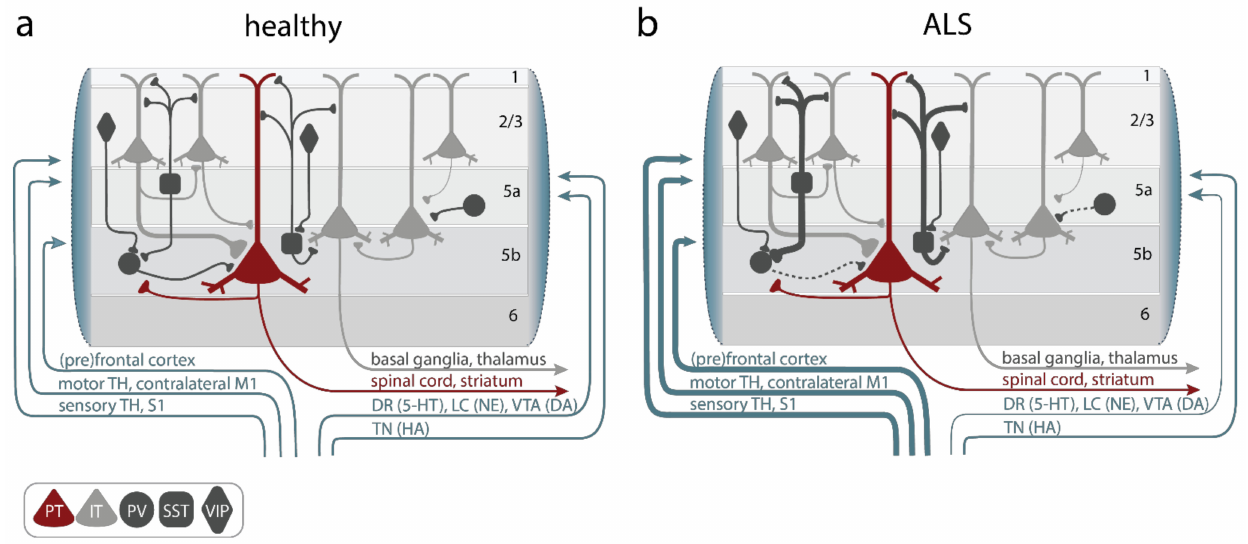
Figure 2. Alterations of primary motor cortex (M1) microcircuit elements in ALS. ( a ) In the healthy M1 microcircuitry upper motor neurons (UMNs), aka, pyramidal tract neurons (PT, red), located within cortical layer 5b receive feedforward excitatory synaptic input primarily from intratelencephalic (IT, light gray) neurons in layer 2–3 and, to a lesser degree, intralaminarly from layer 5 IT. Long- range feedforward input is provided by the (pre)frontal and somatosensory cortex, the contralateral primary motor cortex (M1), and the thalamus (TH). Excitation is controlled by a number of inhibitory GABAergic interneurons, which express either parvalbumin (PV), somatostatin (SST), or vasoactive intestine peptide (VIP) (dark gray). Neuromodulatory input further shapes information processing in M1 and is provided by projections from the locus coeruleus (LC; releasing norepinephrine (NE)), the ventral tegmental area (VTA; releasing dopamine (DA)), the dorsal raphe (DR; releasing serotonin (5-HT)), or the tuberomammillary nucleus (TN; releasing histamine (HA)). ( b ) In ALS, hypoactive PV and hyperactive SST interneurons were reported, as well as increased long-range feedforward excitatory synaptic inputs and elevated functional connectivity, while neuromodulatory inputs were found to be compromised. Line thickness reflects connectivity